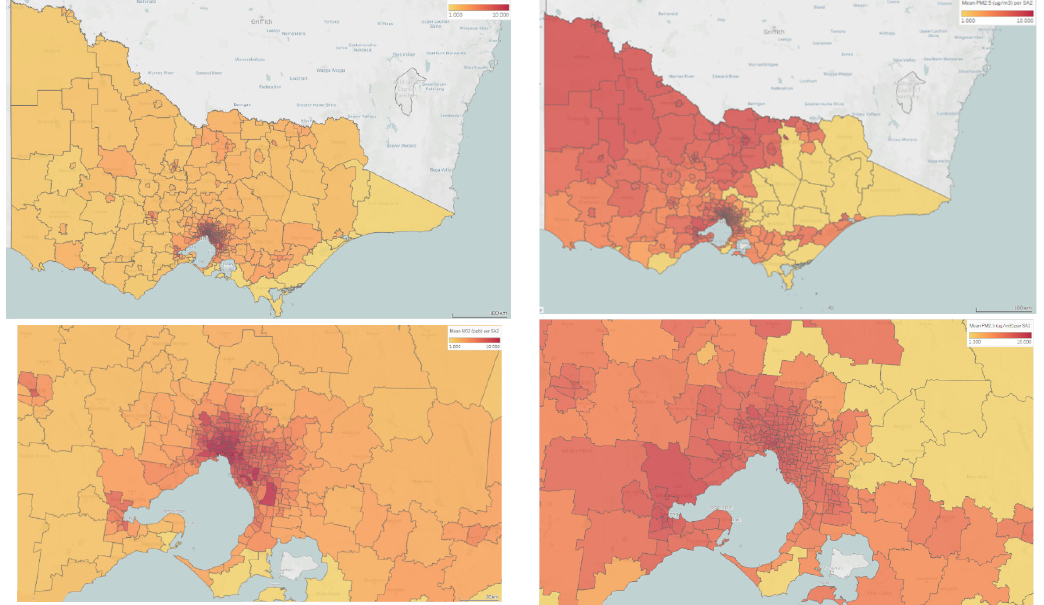
Figure 2. Annual maternal ambient air pollution exposure assigned to maternal residence at time of birth mapped to SA2 level for mean ambient annual NO 2 (ppb) (left) and for mean ambient annual PM 2.5 (µg/m 3 ) (right) for the state of Victoria (top) and Greater Melbourne (bottom).